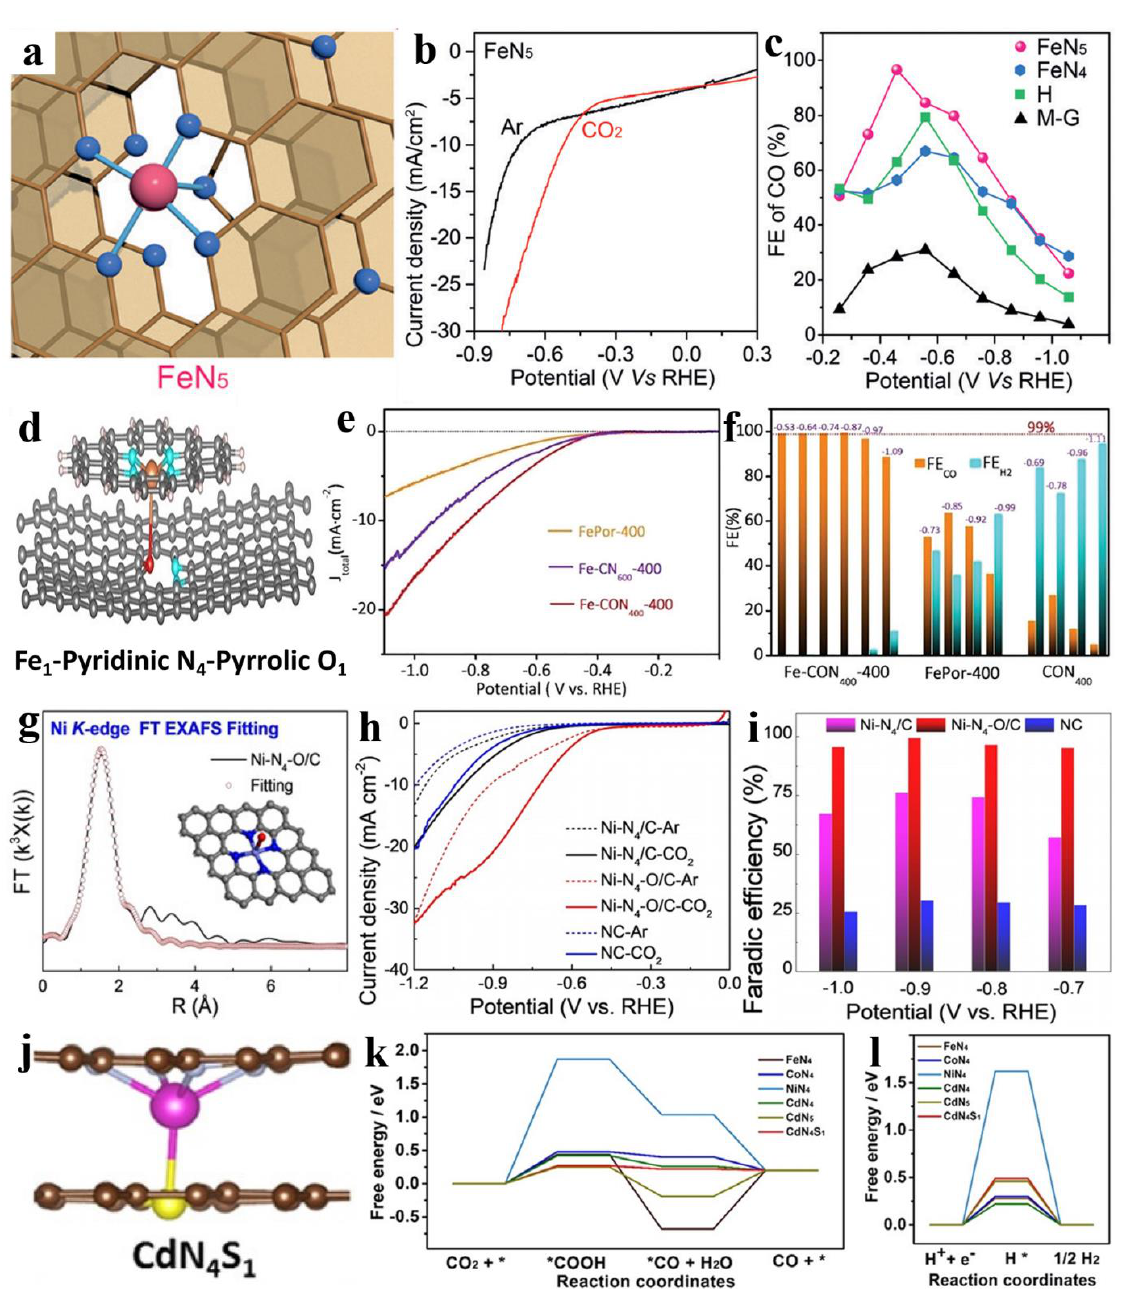
Figure 6. ( a ) The local structure of FeN 5 catalysts. ( b ) The linear sweep voltammetric (LSV) curves in 0.1 M KHCO 3 solution. ( c ) FE CO . Reprinted with permission from ref. [114]. Copyright: (2019)